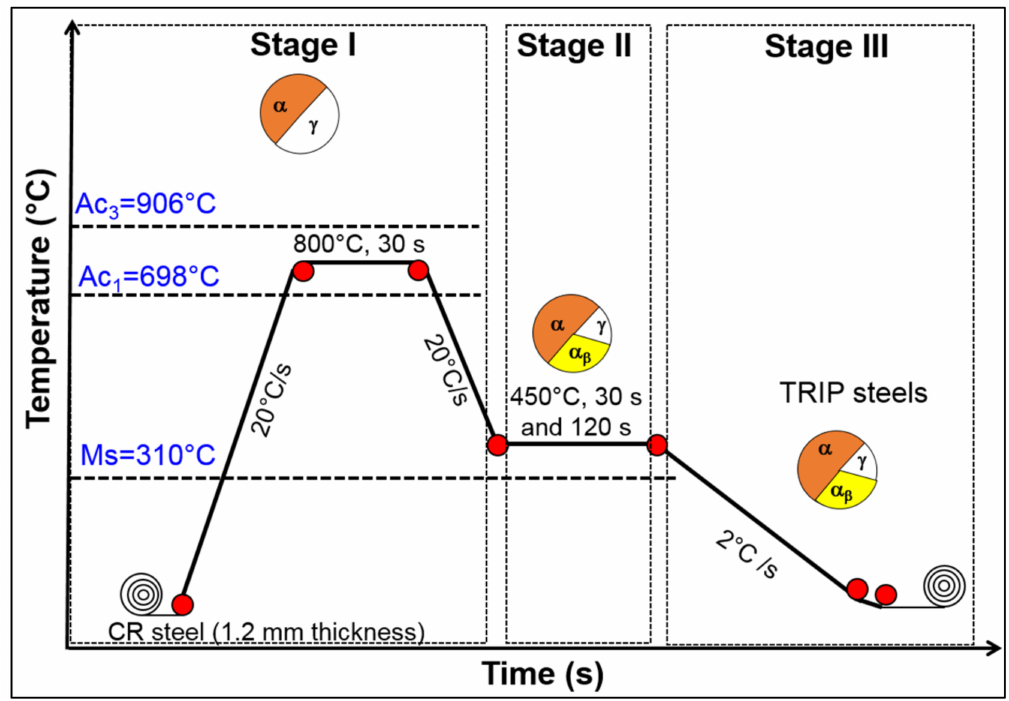
Figure 1. Thermal treatment parameters employed to obtain TRIP steels: stage ( I ) intercritical annealing, stage ( II ) isothermal bainitic treatment, stage ( III ) final